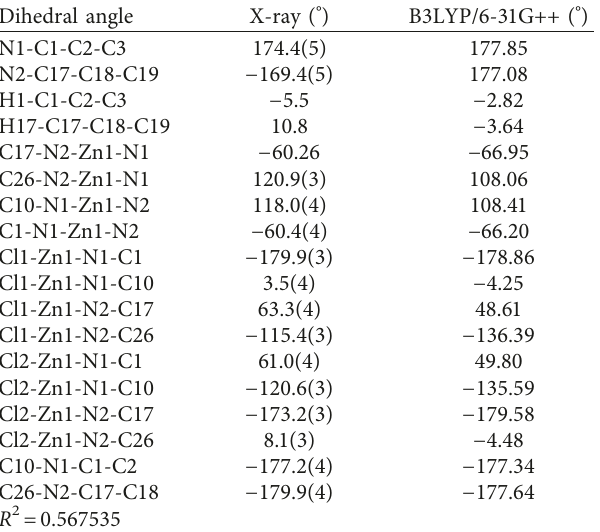
Table 4: Selected dihedral angles (experimental and calculated) for the [ZnCl 2 (BS-4-OCH 3 ) 2 ] complex.